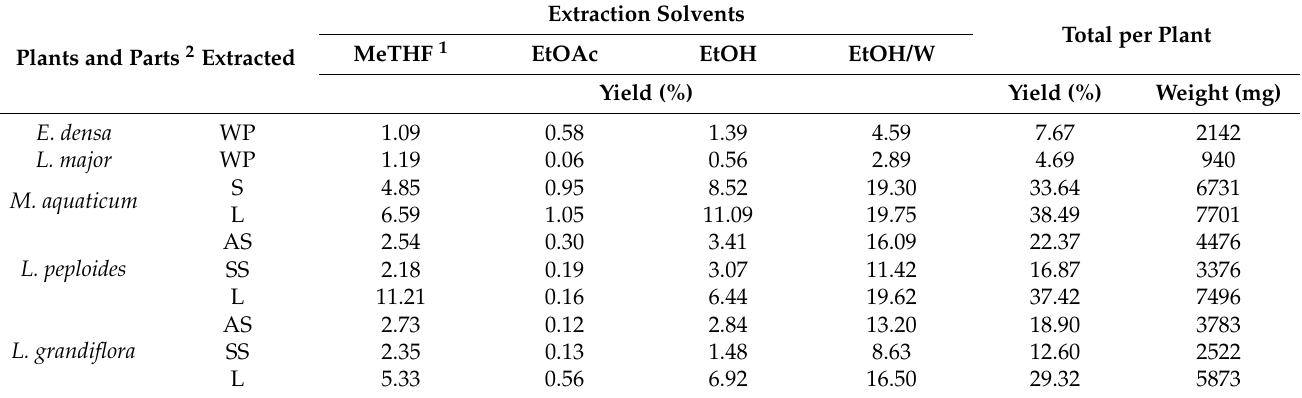
Table 1. Extraction yields of different invasive plant parts, obtained with four solvents. Extraction Plants and Parts 2 Extracted